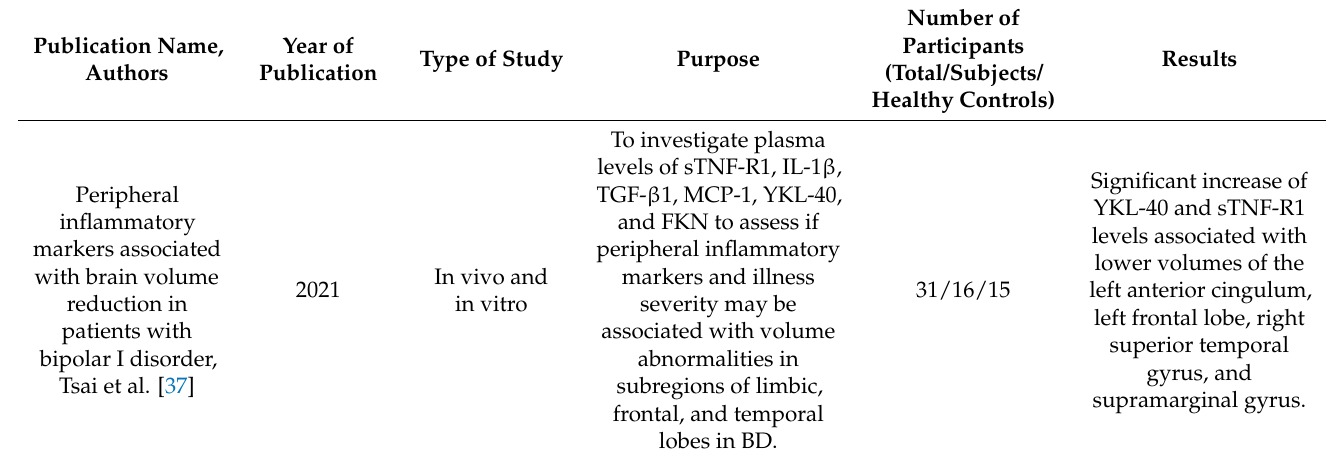
Table 3. Summary of combination in vivo and in vitro publications included in the scoping